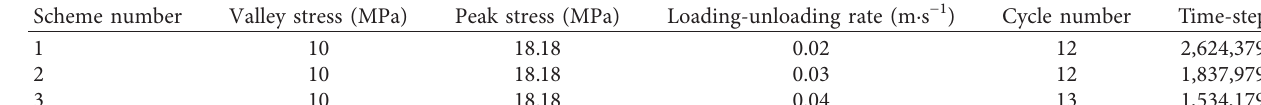
Table 4: Test conditions and results of coal specimen subjected to cyclic loading.